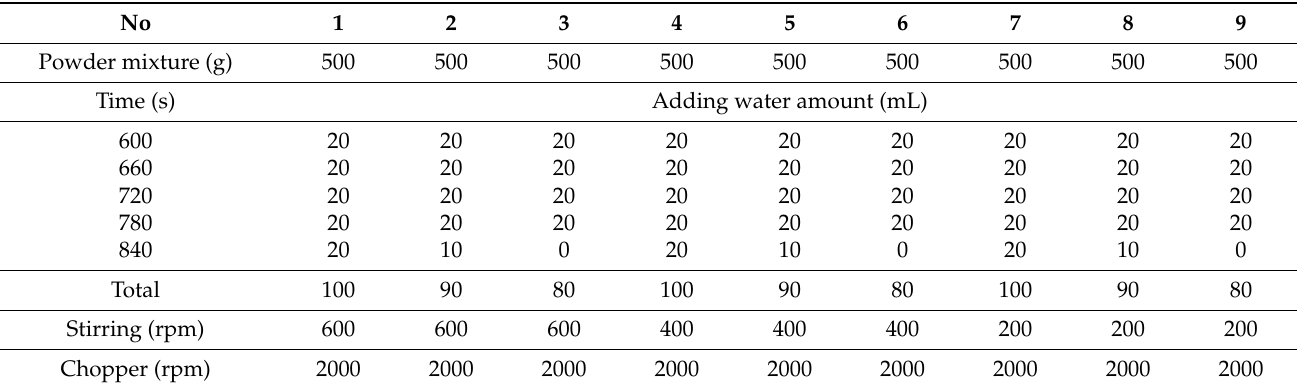
Table 2. Preparation of HSWG granules for analyzing the granulation mechanism under various experimental